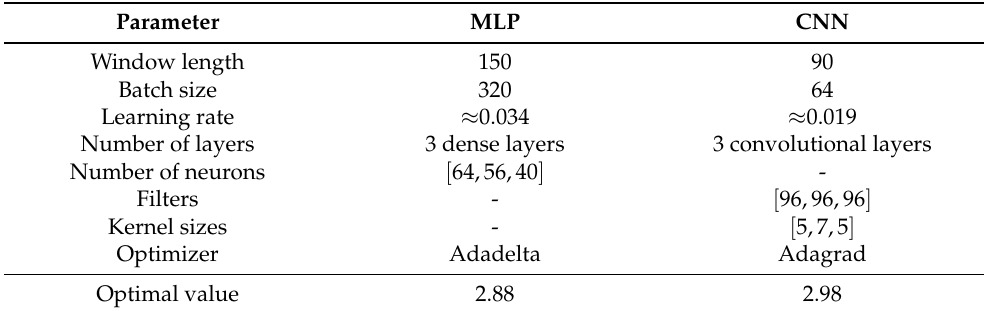
Table 4. The best configurations for the two study model types.